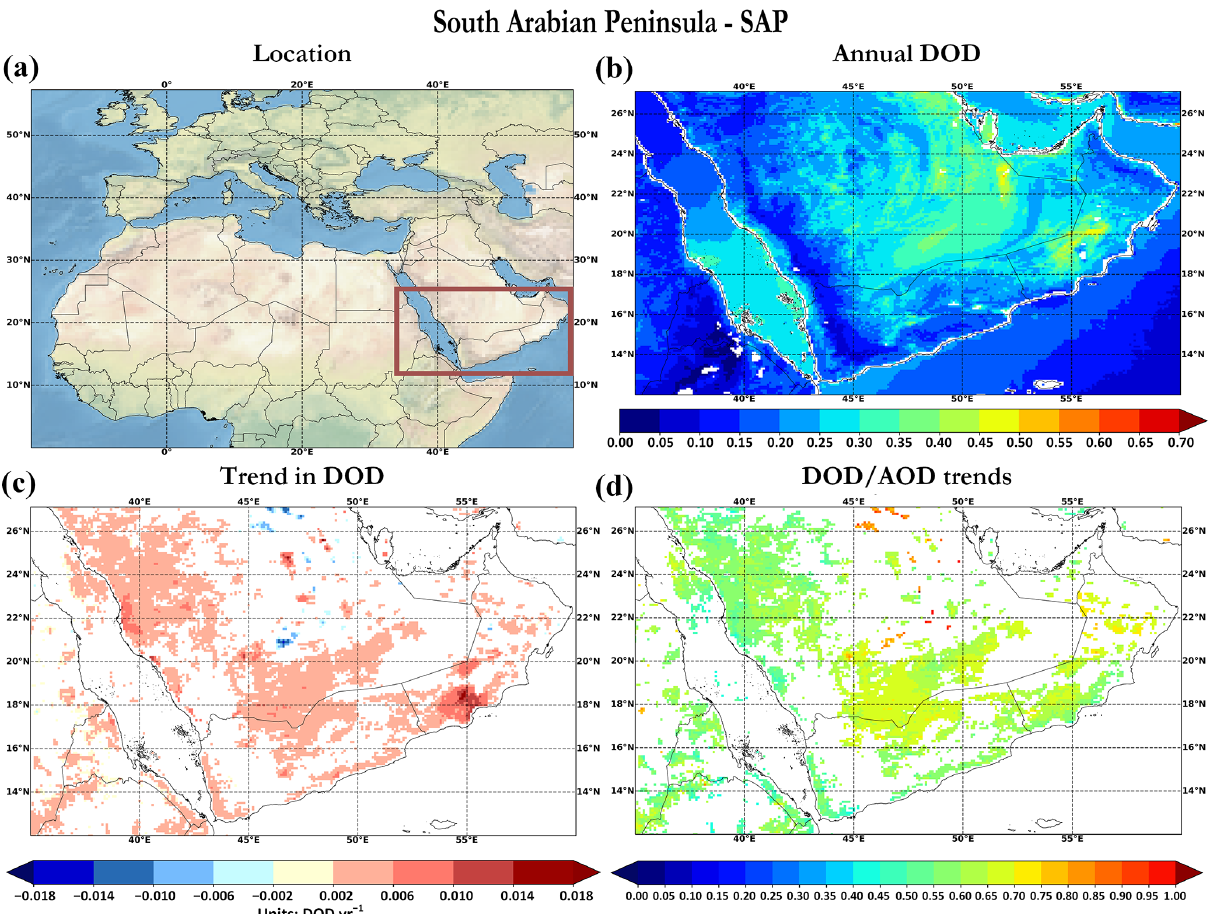
Figure 15. Same as Fig. 10, but for the southern Arabian